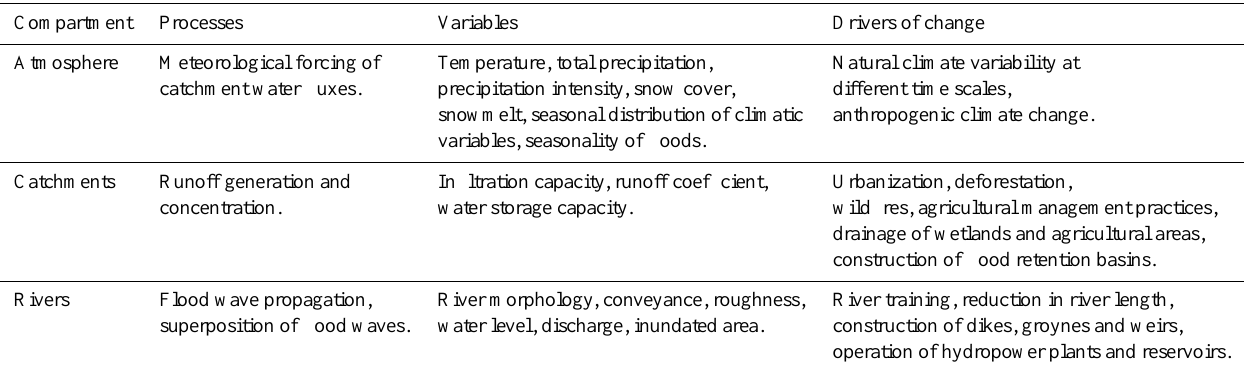
Table 1. Examples of drivers of change in flood hazard and associated